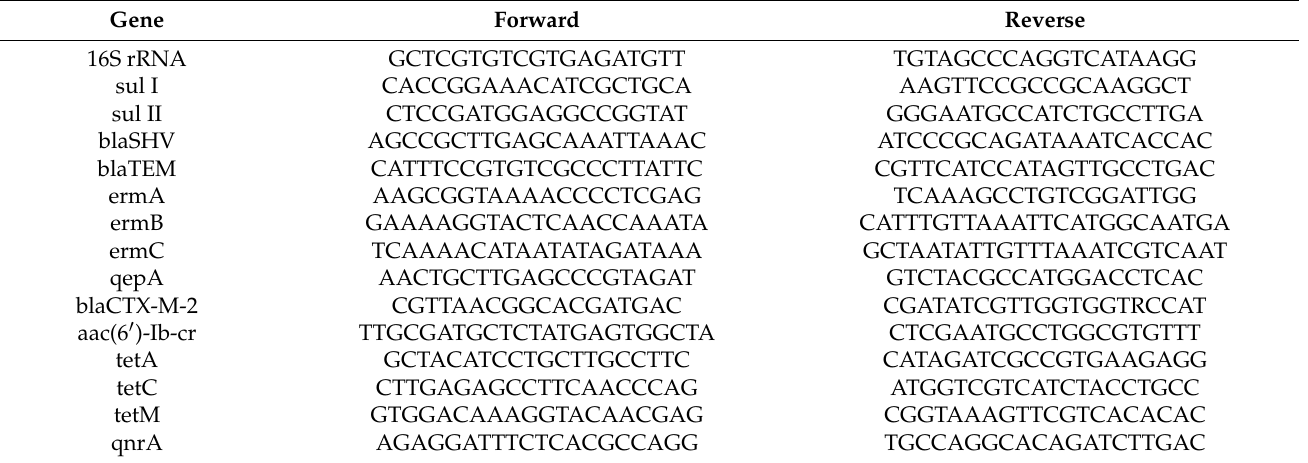
Table 1. The primer sequences of selected drug-resistant